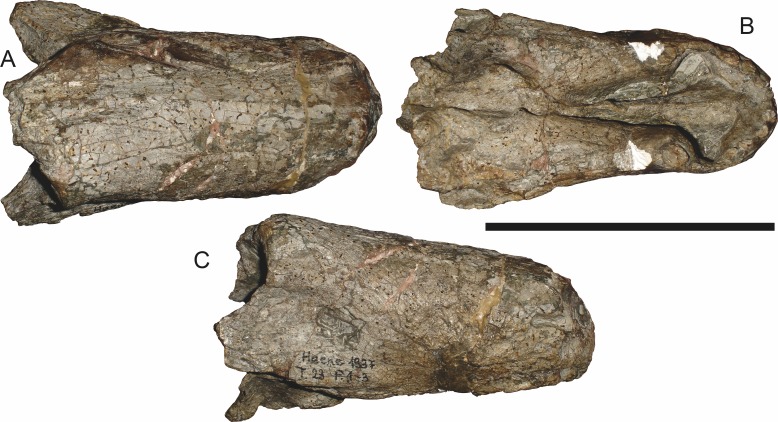
Referred specimen (GPIT/RE/7134) of Sycosaurus laticeps (Haughton, 1924) in (A) dorsal, (B) ventral, and (C) right lateral view.Scale bar equals 10 cm.